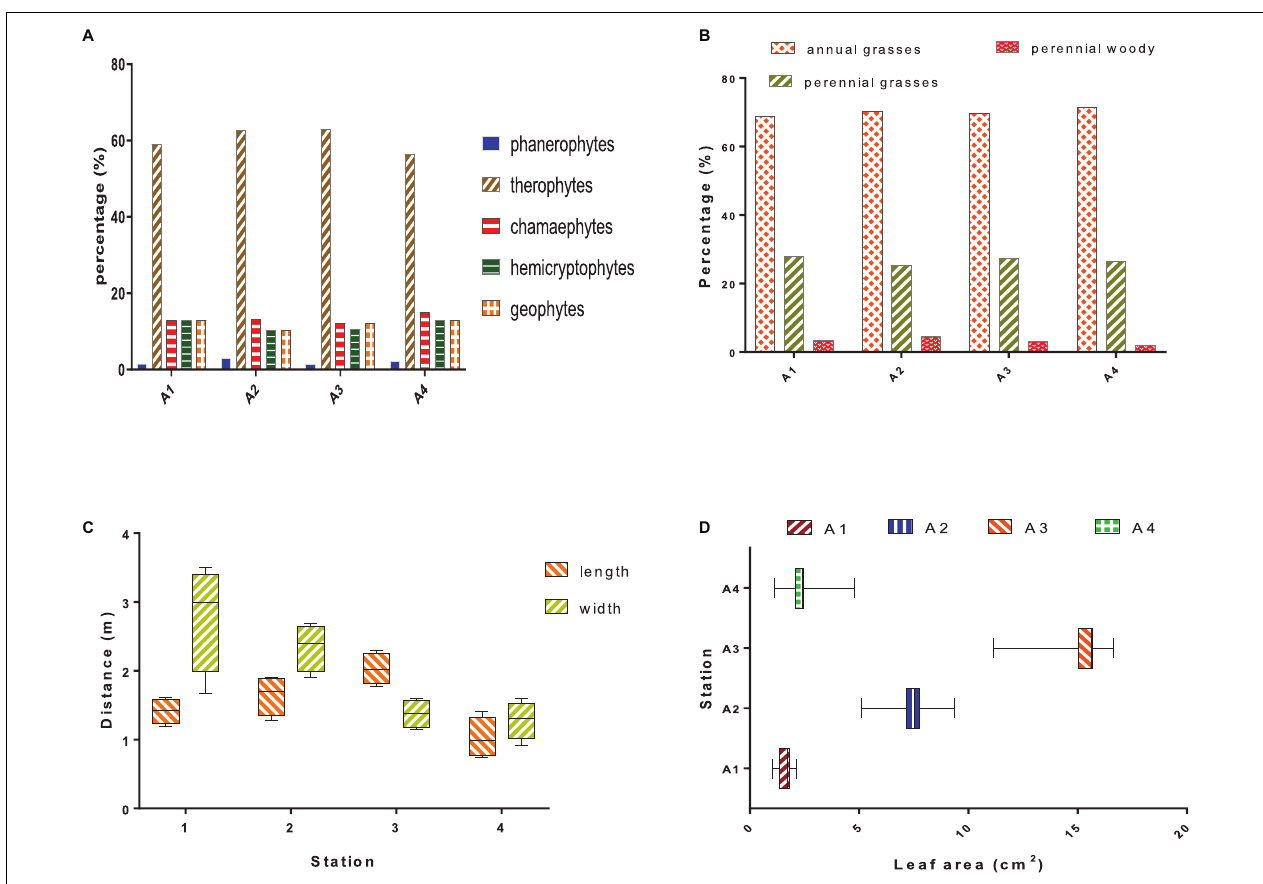
FIGURE 4 | (A) Percentages of plant life forms in the study area. (B) Percentages of morphological types. The length and width (C) and leaf area (D) of Withania frutescens (L.) Pauquy in study stations.